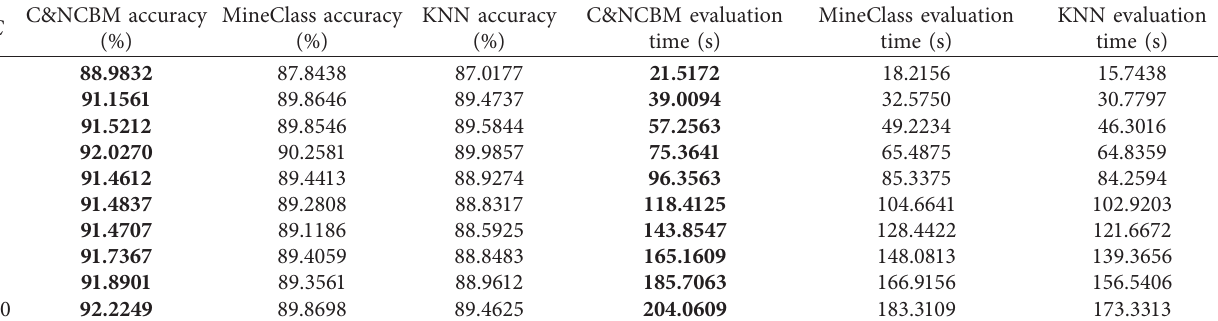
Table 5: Experimental result data in Covertype